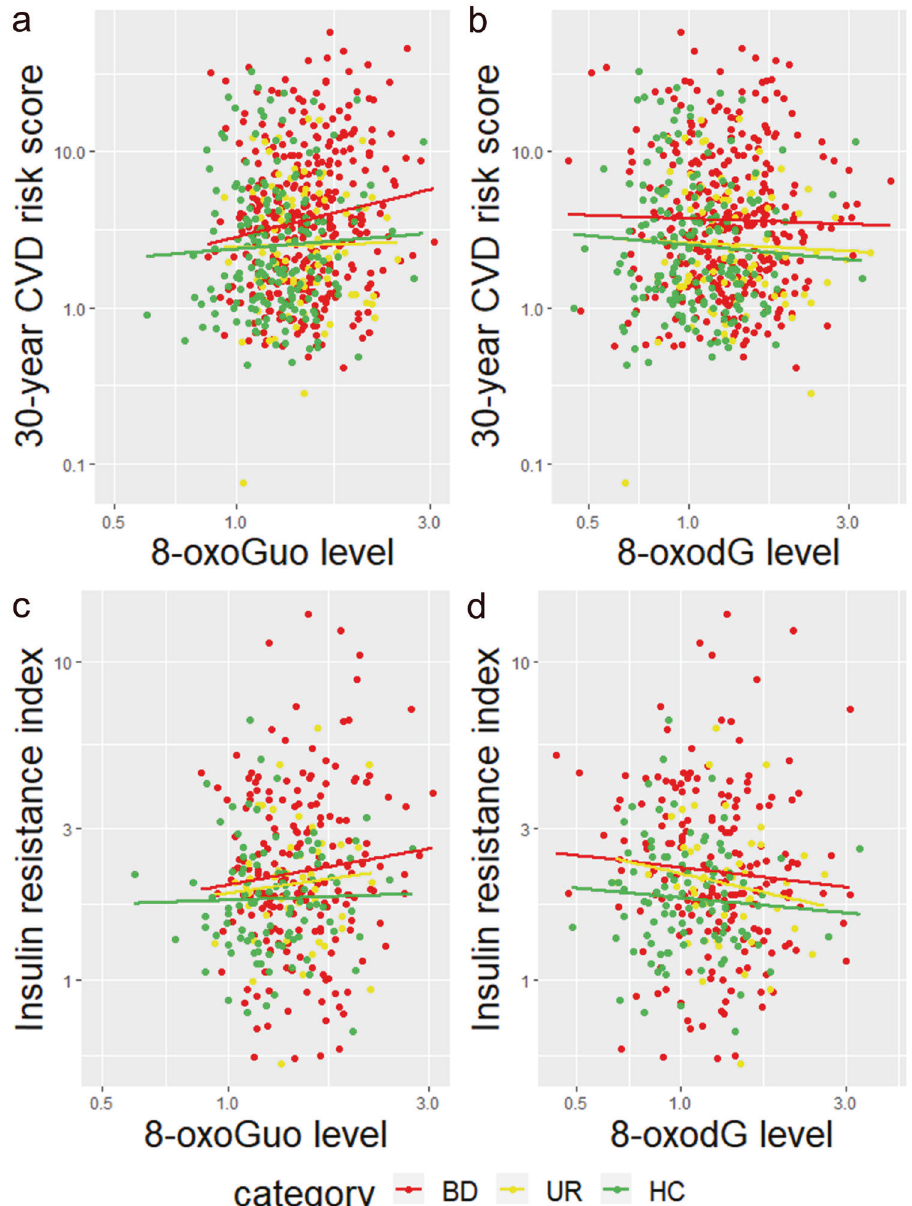
Fig. 1 Associations between cardiovascular disease risk measurements and oxidative stress in the complete study population. Scatter plot of the 30-year cardiovascular disease risk score against levels of 8-oxoGuo ( a ) and 8-oxodG ( b ) and insulin resistance index against levels of 8-oxoGuo ( c ) and 8-oxodG ( d ). Fit lines are drawn for the three subgroups individually. BD bipolar disorder, UR unaffected relatives, HC healthy control individuals. Outcome variables were transformed by the natural